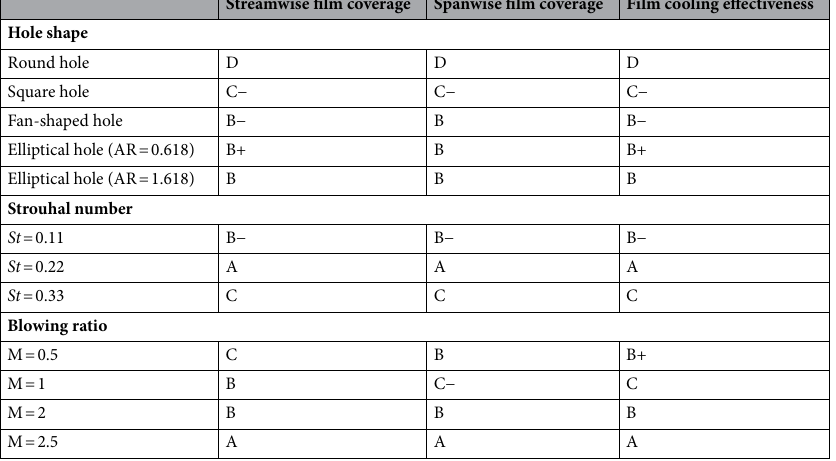
Table 2. Comparison of the influence of different factors on the film cooling of the synthetic